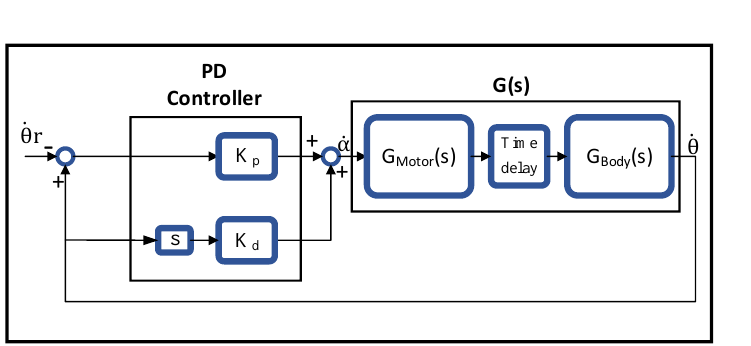
Figure 7. Closed-loop system using PD controller.